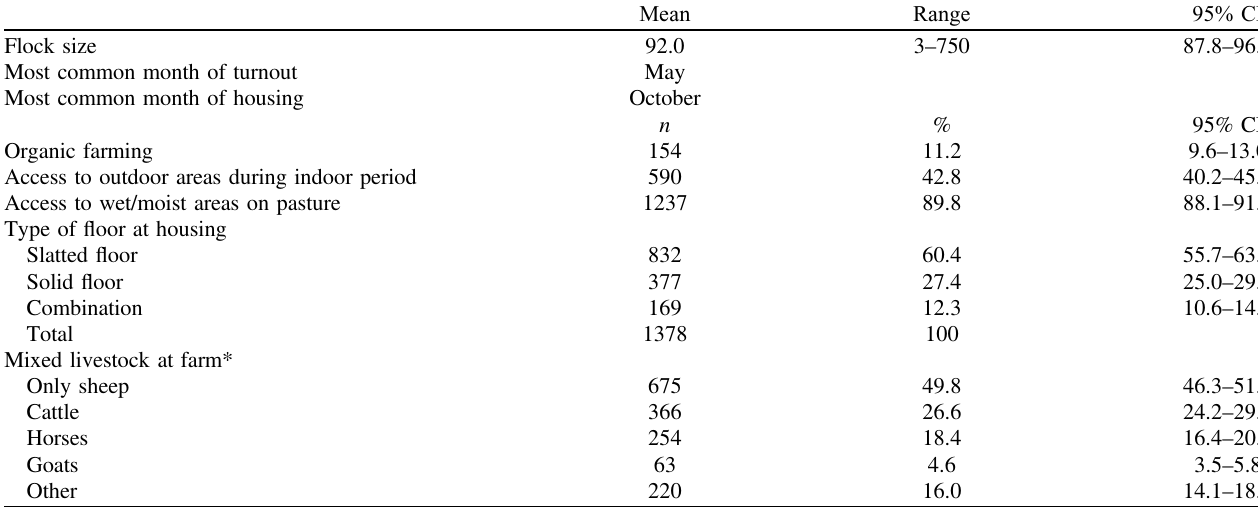
Table 1. Descriptive data of Norwegian sheep fl ocks in the present survey ( n = 1378).